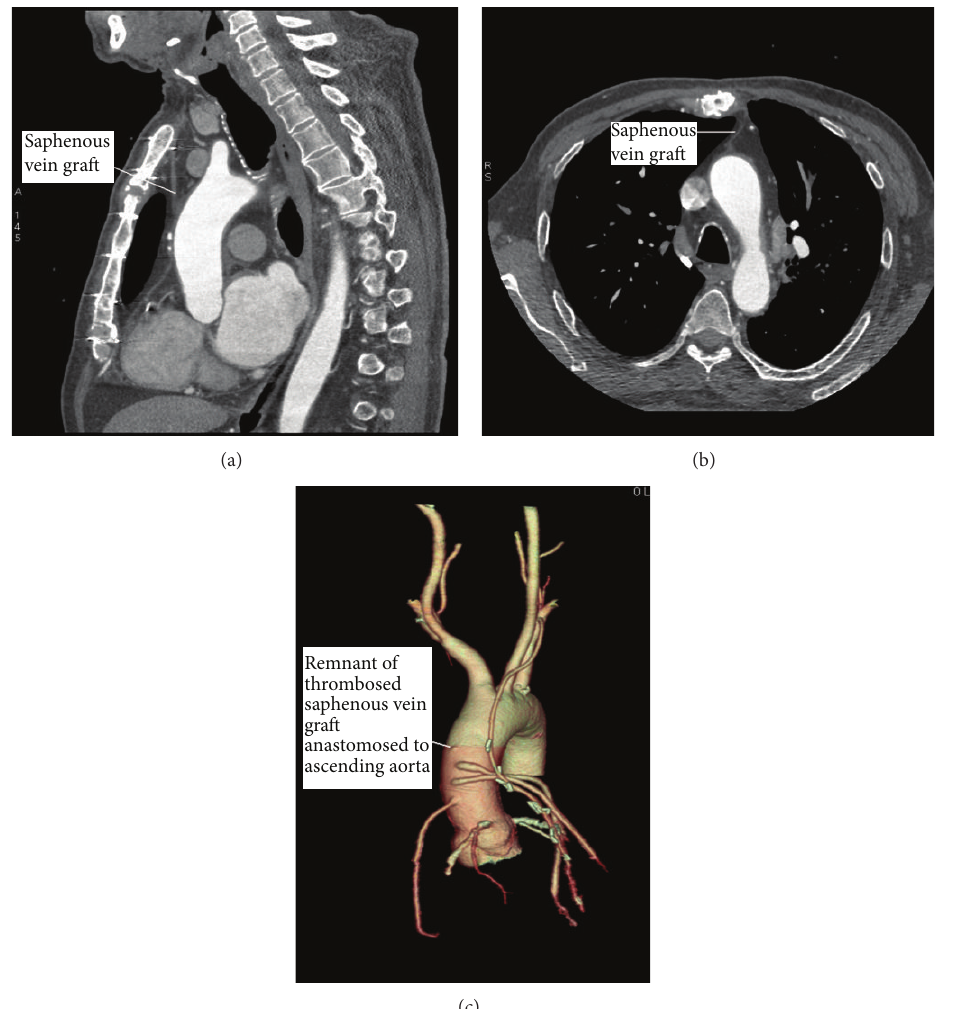
Figure 3: At postoperative 6th month, multislice CT imaging shows thrombotic occlusion at the remnant of the saphenous vein graft. (a) Sagittal section imaging of thrombosed saphenous vein graft. (b) Cross-sectional appearance of thrombosed saphenous vein graft. (c) Three- dimensional display of remnant of thrombosed saphenous vein graft anastomosed